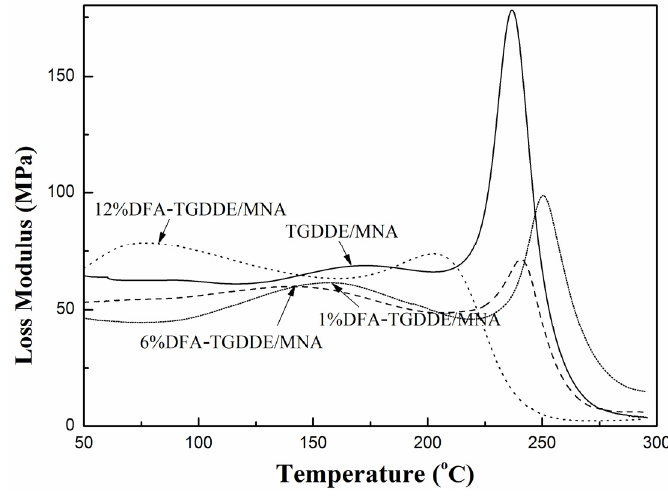
Figure 8. Storage modulus curves of the cured resins, 5 °C/min, 1 Hz.